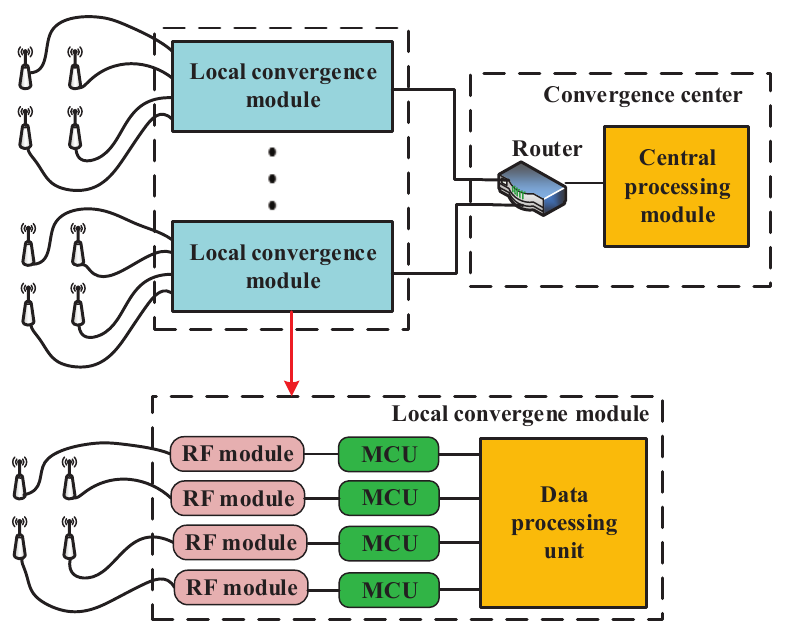
Figure 2. Architecture of the proposed macrodiversity reception